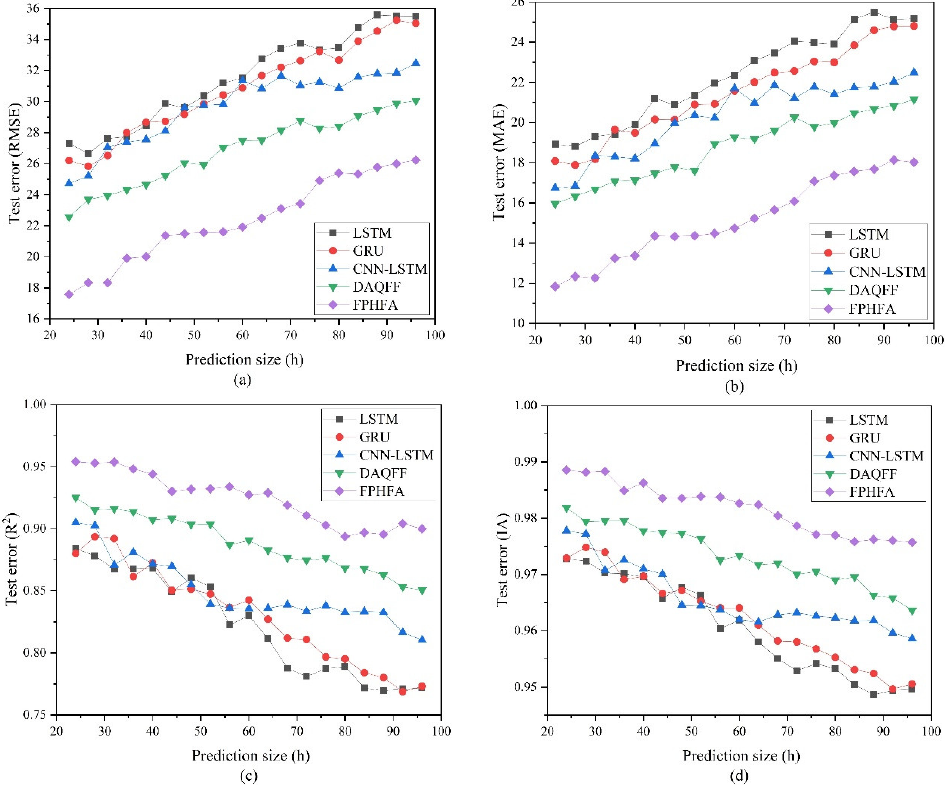
Figure 10. Window size is 56, number of epochs is 150, and batch size is 128. RMSE, MAE, R 2 , and IA of models at different prediction sizes in the Beijing dataset. ( a ) RMSE. ( b ) MAE. ( c ) R 2 . ( d ) IA.